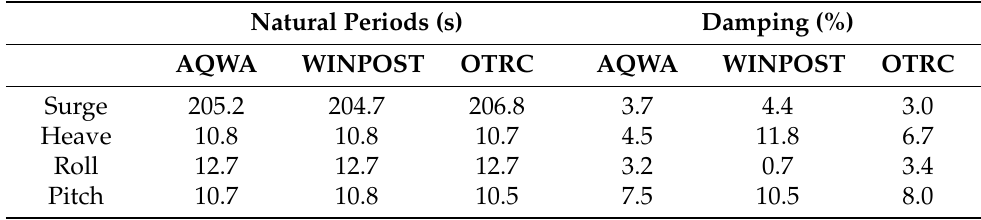
Table 7. Comparison of free decay test results.